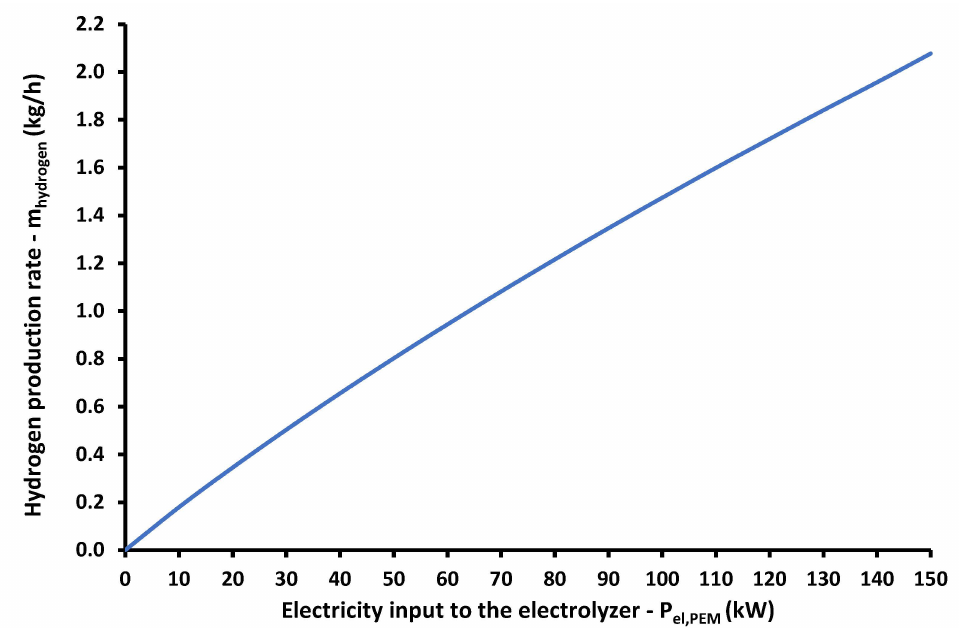
Figure 6. Hydrogen production rate depending on the electricity input to the